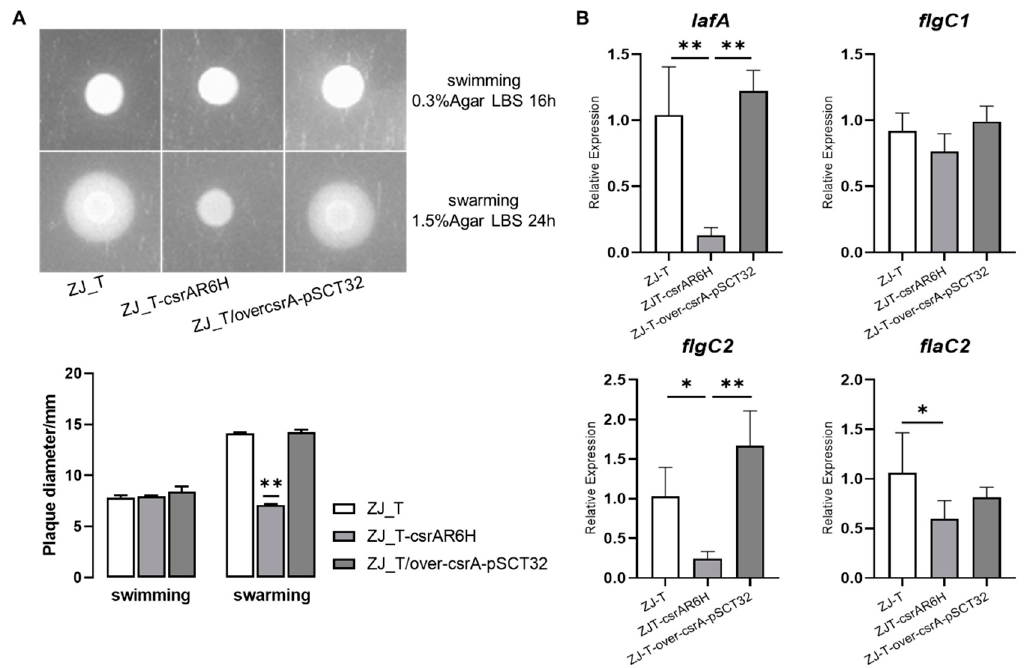
Figure 2. CsrA positively regulates swarming but not swimming motility in V. alginolyticus . ( A ) The ability of ZJ_T, ZJ_T- csrA R6H, ZJ_T/over csrA -pSCT32 to swim or swarm through 0.3% and 1.5% LBS agar plates, which was observed with a BIO-RAD Gel Doc TM XR + imager. The presence of the csrA mutant did not change the swimming ability, but it decreased the swarming ability. The bars represent the mean of three biological replicates, the error bars are the standard deviations, and the p values were calculated using one-way ANOVA (* p < 0.05, ** p < 0.01) comparing ZJ_T- csrA R6H to both the wild type and the overexpression strain. ( B ) Relative expression levels of lateral flagellin ( lafA ), flagellar basal-body rod protein ( flgC1 ), flagellar basal-body rod protein C ( flgC2 ), flagellin ( flaC2 ). lafA , flgC2 , flaC2 were significantly downregulated and displayed changes of greater than 2-fold (Baggerley’s test, FDR p value of <0.05) in the expression in the csrA mutant compared with the wild-type strain, while flgC1 was downregulated but not significantly. Error bars indicate standard deviations.